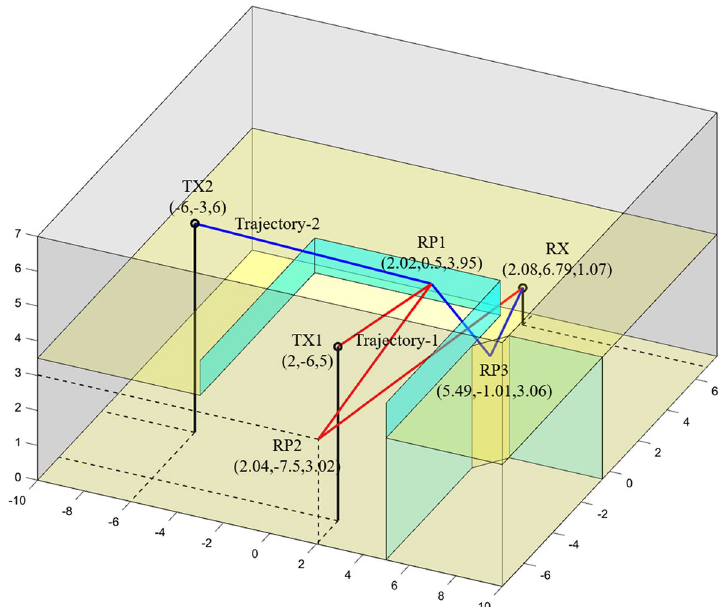
Fig. 11 Two trajectories between TX1-RX and TX2-RX in an indoor environment